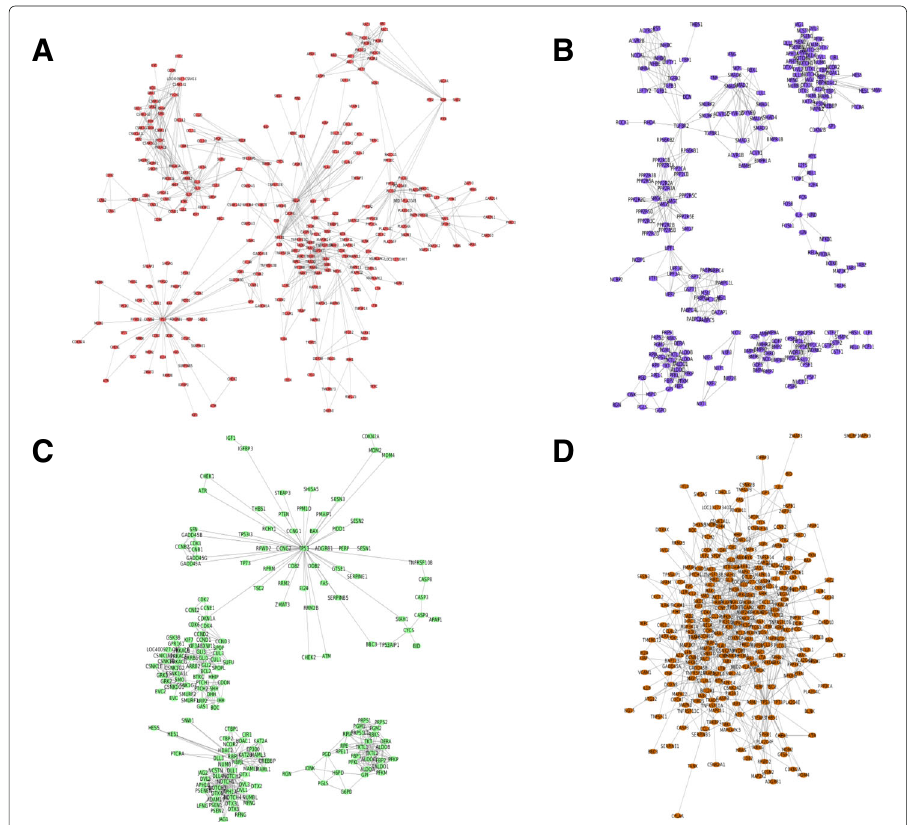
Fig. 1 Network visualizations. Panel a , MainNetwork . Panel b , AlternativeNetwork . Panel c , MixedNetwork . Panel d ,